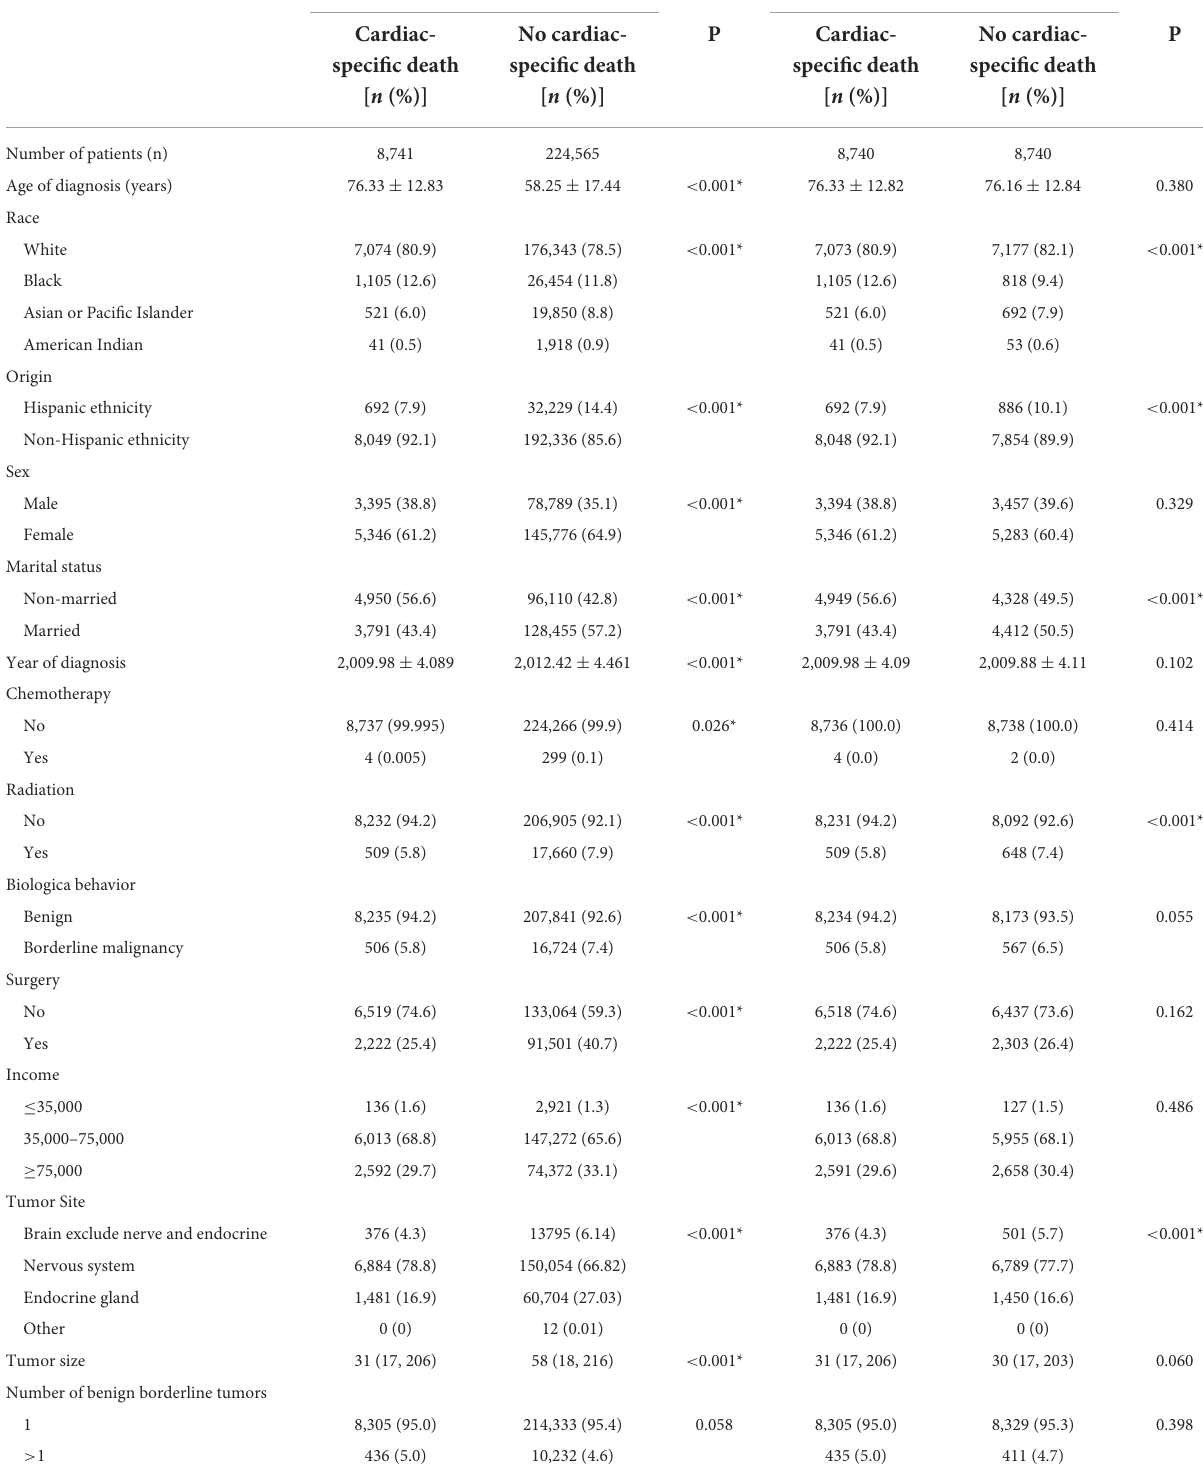
TABLE 1 Characteristics of patients included in non-malignant tumor